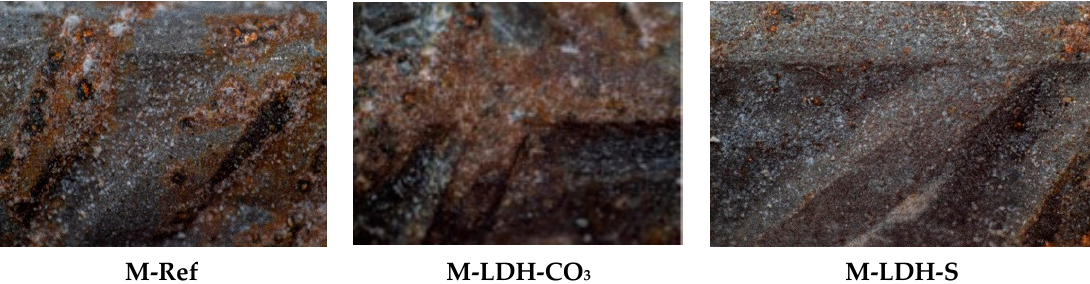
Figure 11. Total charge associated with the corrosion period (exposure to chloride action) for each Figure 11. Visual aspect of the rebars at the end of the studied rebar.